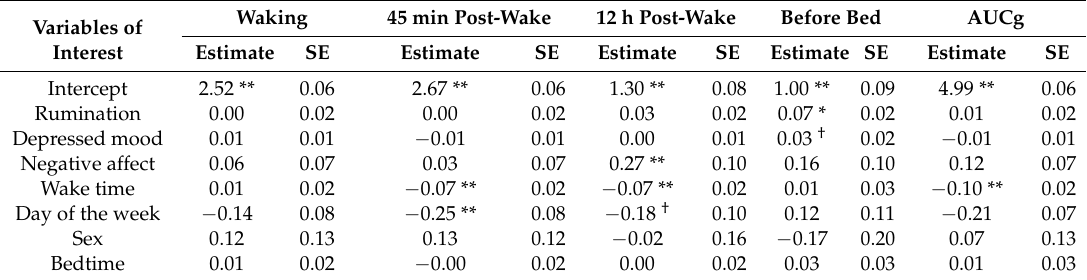
Table 1. Salivary cortisol indices as predicted by rumination and other variables of